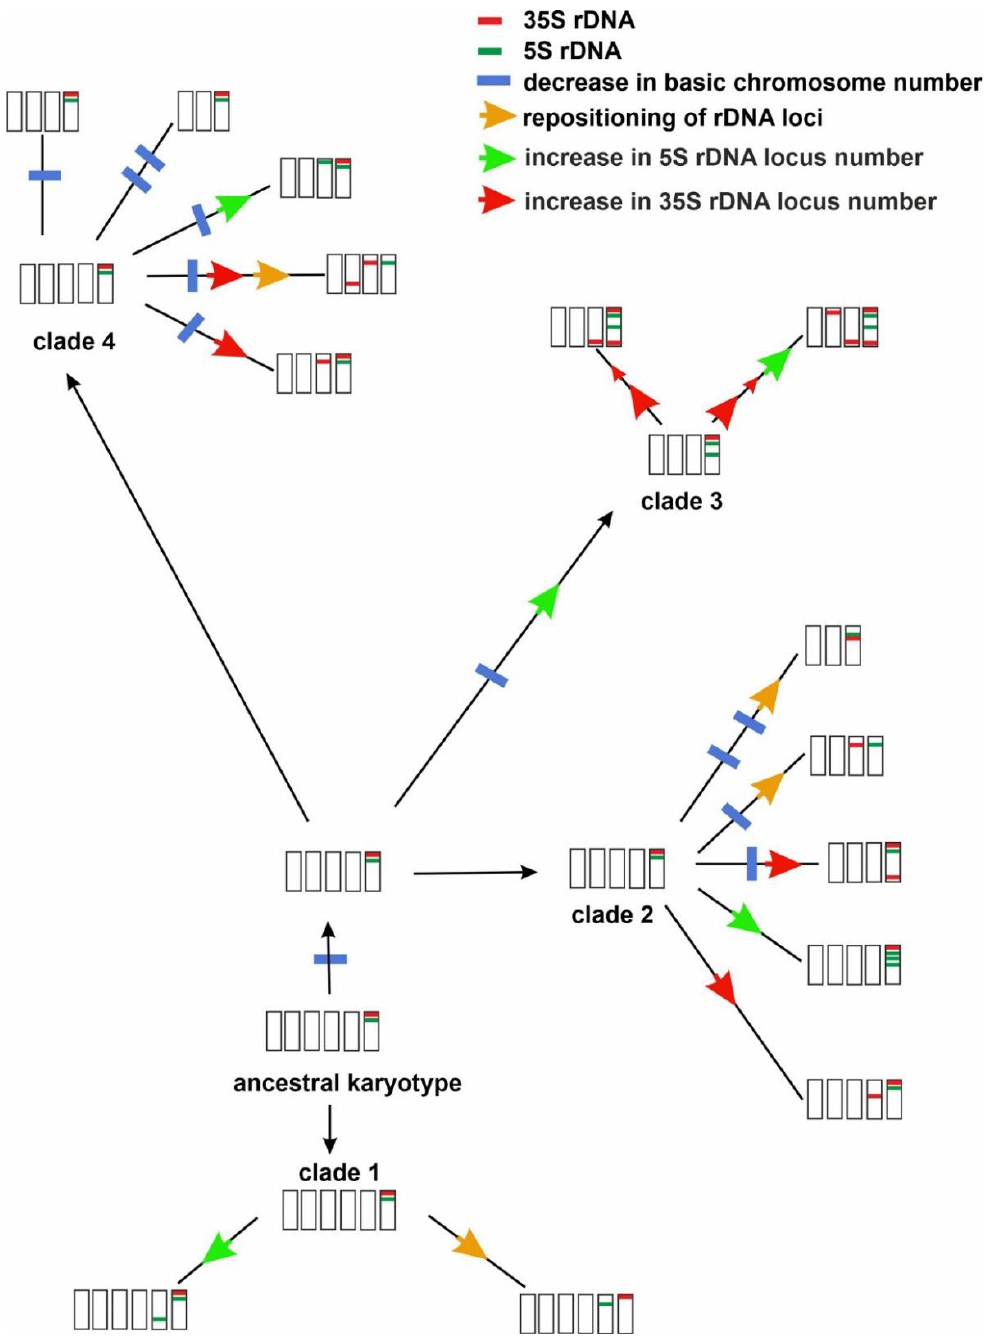
Figure 8. Hypothesis on the evolution of base chromosome numbers and rDNA loci number and localisation in Crepis s.s.